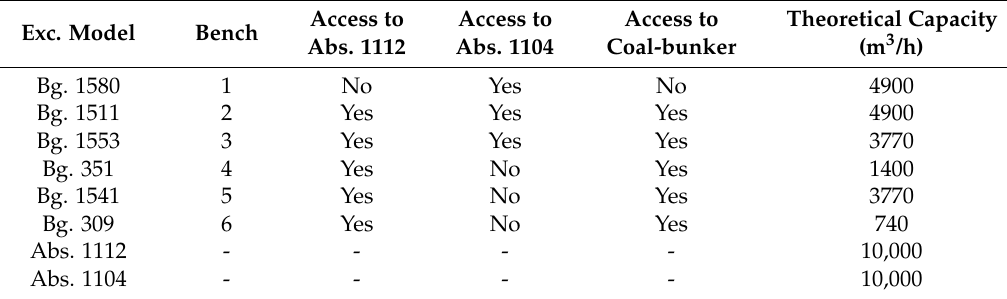
Figure 5. Schematic overview of the production system in the Profen mine. Table 2. An overview of the specifications of the